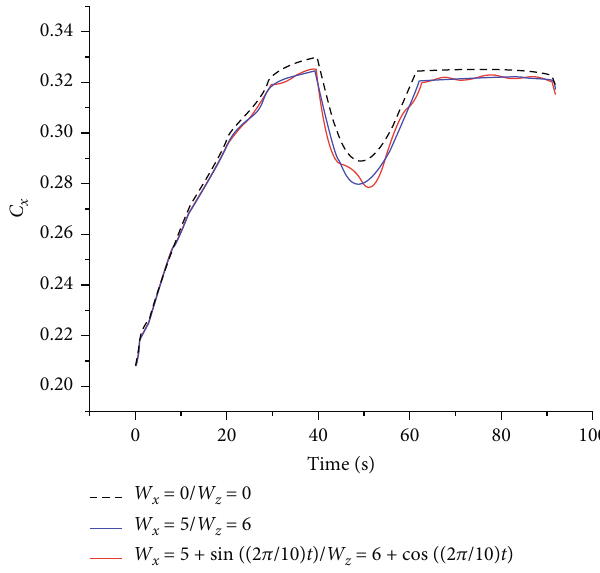
Figure 4: Variation curve of the drag coe ffi cient under three